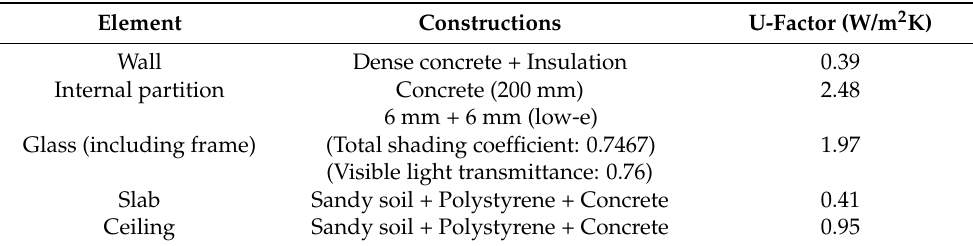
Table 1. Building material